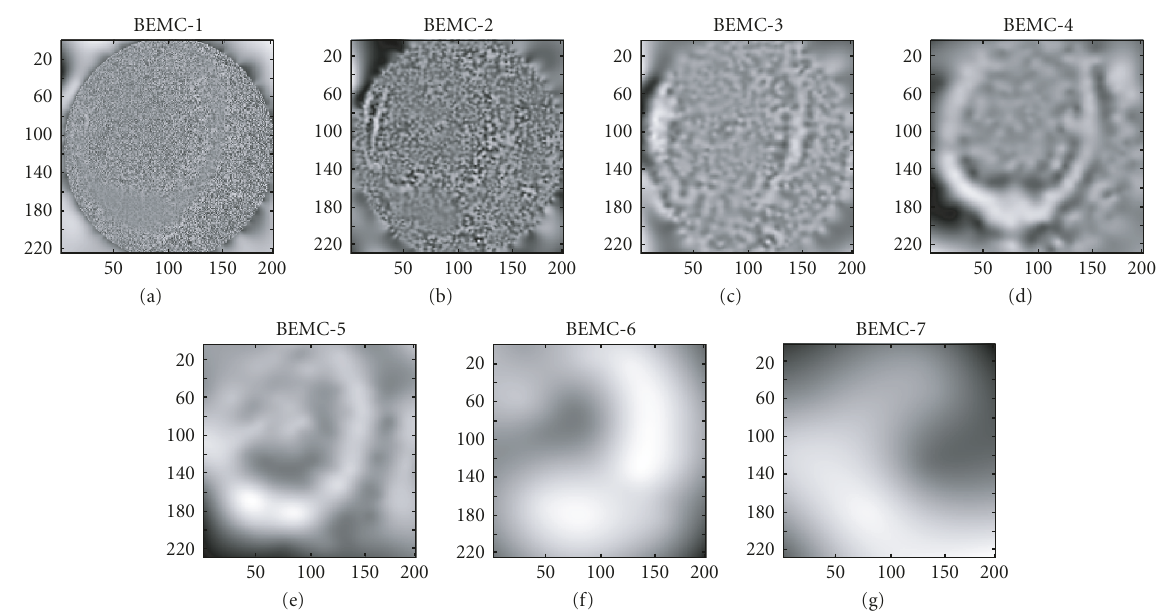
Figure 24: BEMCs of noisy aurora image obtained by BEMD with RBF-TPS (MNAI = 10).